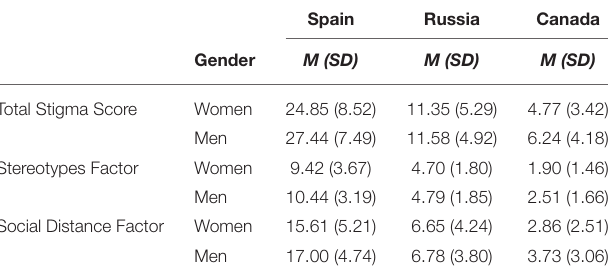
TABLE 3 | Descriptive statistics for stigma between Spanish, Russian and Canadian students by country and